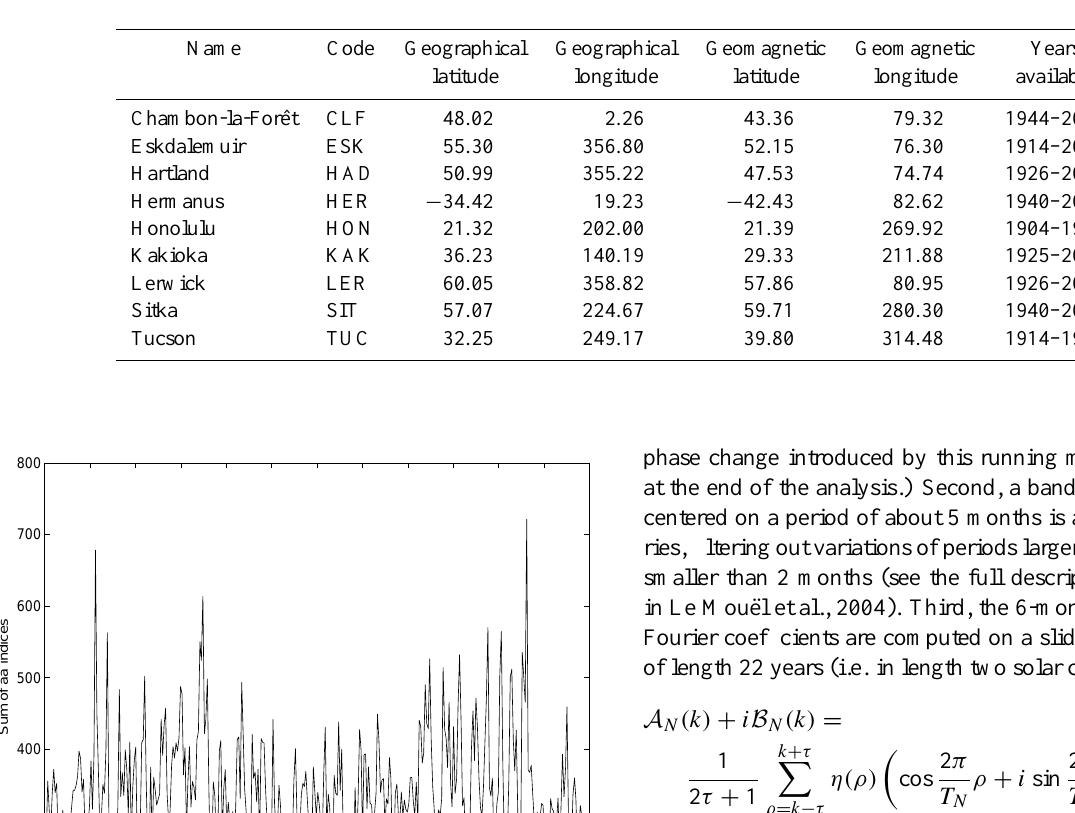
Table 1. Names, codes and coordinates of magnetic observatories used in the study, and years available.